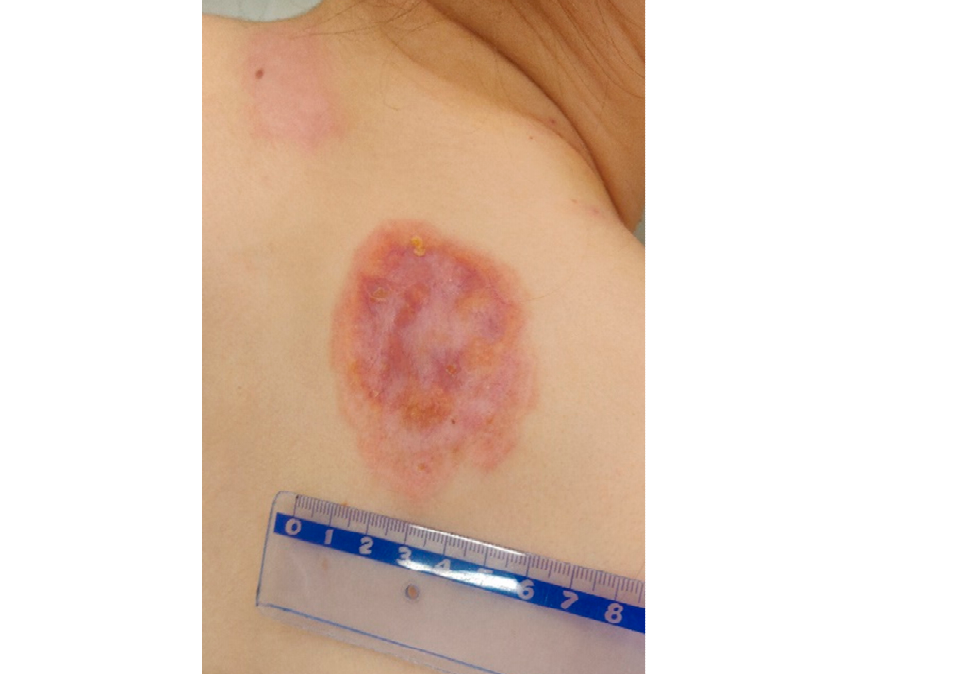
Figure 14. The right scapula on the last day of hospitalisation. 4. Discussion Late symptomatic syphilis is a rare systemic disease that can affect the skin, the mu- cous membranes, the circulatory system, the nervous system and the skeletal system. The incidence of tertiary syphilis decreases significantly with the introduction of penicillin in its early stage, but new cases of this disease are still being reported [12,13,13,14,14–17,17– 79]. It is estimated that about 25% of untreated patients will develop tertiary syphilis [82]. A conviction about the casuistic occurrence of late symptomatic syphilis does not allow doctors to take it into account in a differential diagnosis of non-standard symptoms. Le- sions in tertiary syphilis are not infectious and contain a practically undetectable number of spirochetes, while serum reactions are highly positive. One person can develop more than two forms of this disease. Skin lesions in tertiary syphilis are tubero-serpiginous